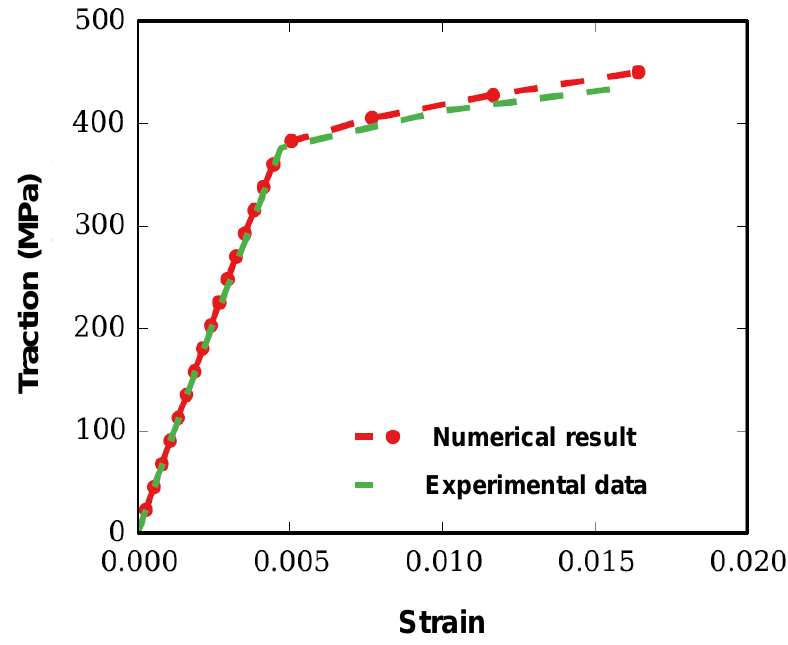
Figure 6. Comparison of numerical and experimental strain-stress curves for the composite.